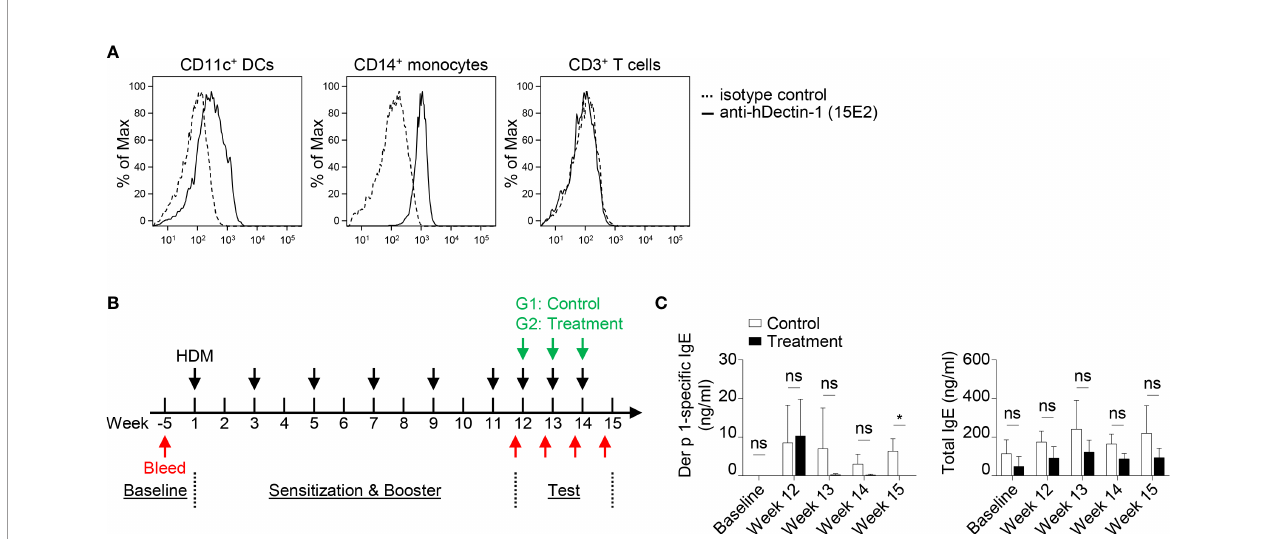
FIGURE 7 | Anti-hDectin-1-Pam 3 CSK 4 Conjugate Can Suppress Allergen-Speci fi c IgE Response in Macaques In Vivo. (A) Anti-hDectin-1 mAb (clone 15E2) bound to CD11c + DCs and CD14 + monocytes in macaque PBMCs. Representative FACS data of fi ve animals is shown. (B) Scheme of the second in vivo test in NHP. Injection of HDM extract, bleeding, and treatment with anti-hDectin-1-Pam 3 CSK 4 conjugate was performed as indicated. (C) Der p 1-speci fi c IgE and total IgE in the serum of animals at indicated time points were measured by ELISA. Data in (C) are represented as mean ± SD. Signi fi cance was determined using two-way ANOVA with Tukey multiple comparisons test for (C) . * p < 0.05 for the comparison between groups. ns, not signi fi